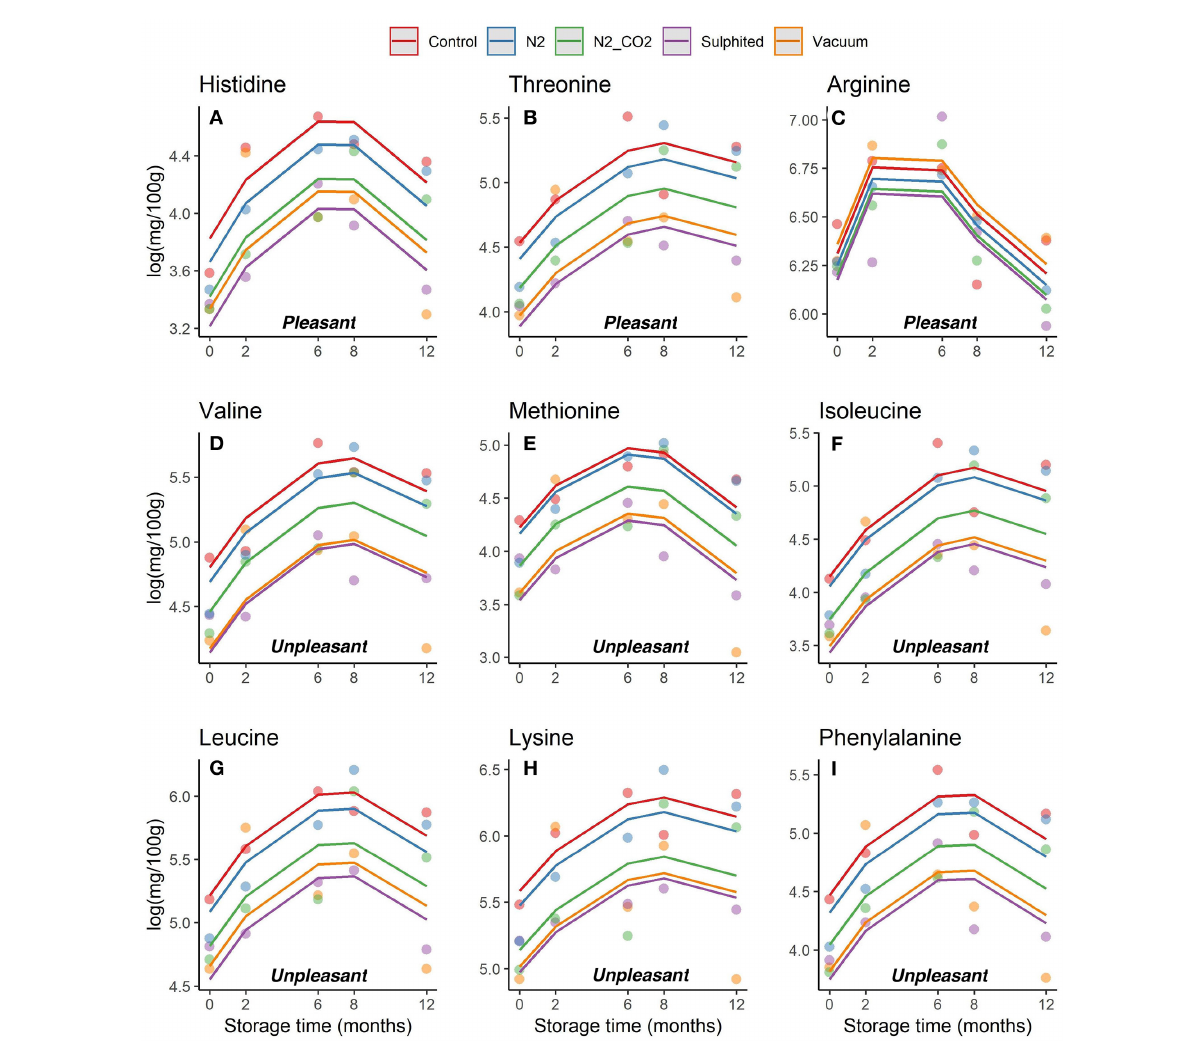
FIGURE4 (A–I) Trends obtained for each essential FAA in DWRS samples in relation to the packaging method over 12 months of frozen storage. FAAs were grouped as pleasant and unpleasant.